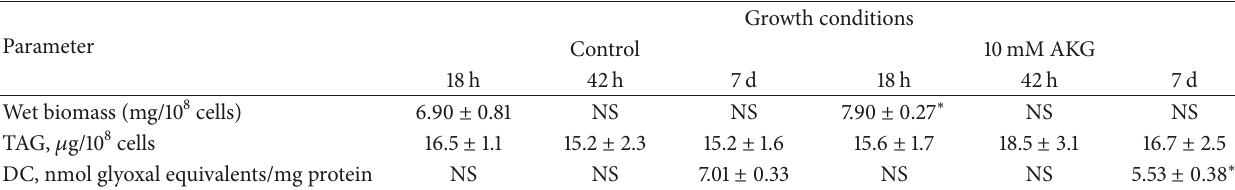
Table 1: Wet biomass and levels of 𝛼 -dicarbonyl compounds (DC) and triacylglycerides (TAG) in S. cerevisiae cells during prolonged cultivation in the control or 10mM AKG-supplemented